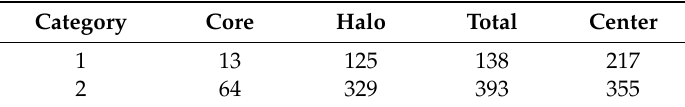
Table 4. Clustering result.